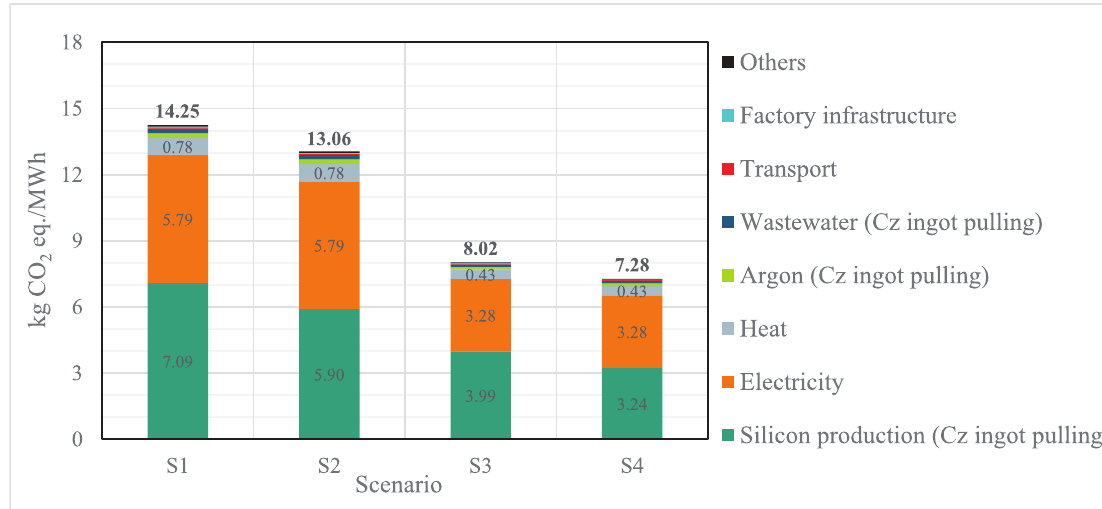
Fig. 4. Climate change impacts for scenarios 1 – 4 (for silicon within the PV